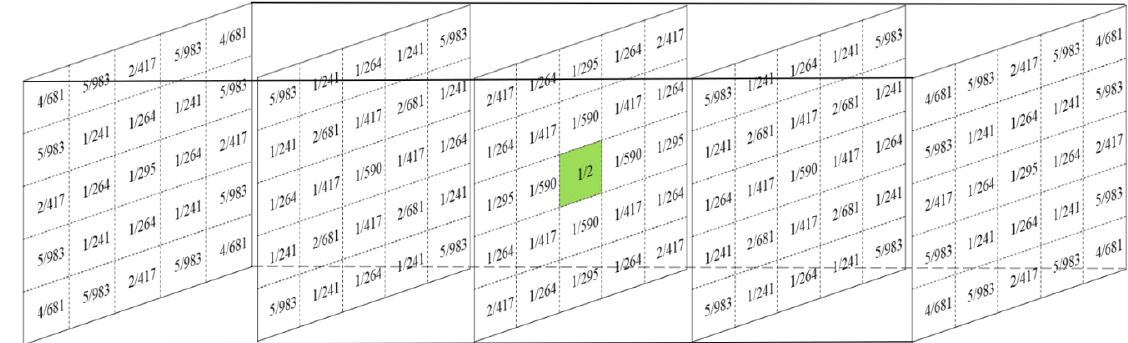
Figure 4. Schematic of the 3D high-pass filtering convolution kernel: the size of the convolution kernel is 5 × 5; its center pixel (green) is 1/2; others are determined according to the distance from the pixel to the center based on the inverse distance weighted method; the sum of the pixels of the entire convolution kernel is 1.